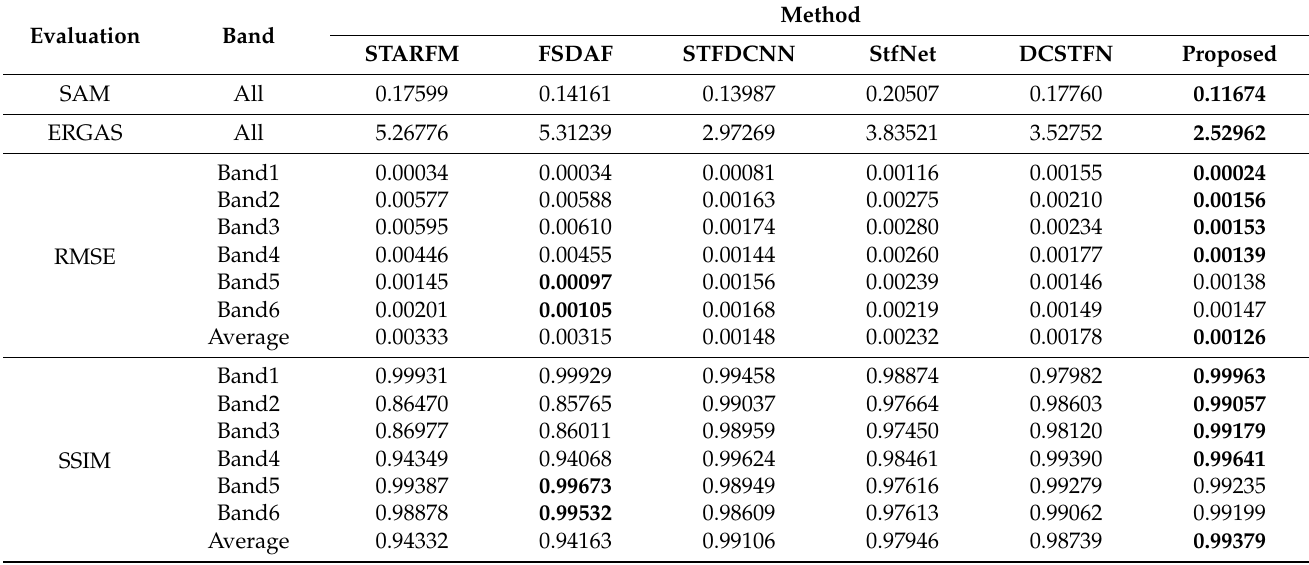
Table 3. Objective metrics of different fusion methods for the AHB